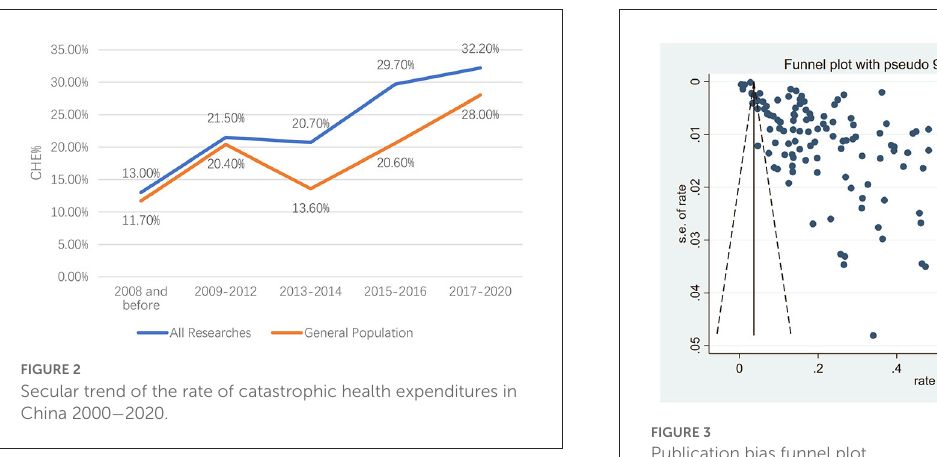
group and 27.8% (95% CI: 22.0% − 33.5%) for